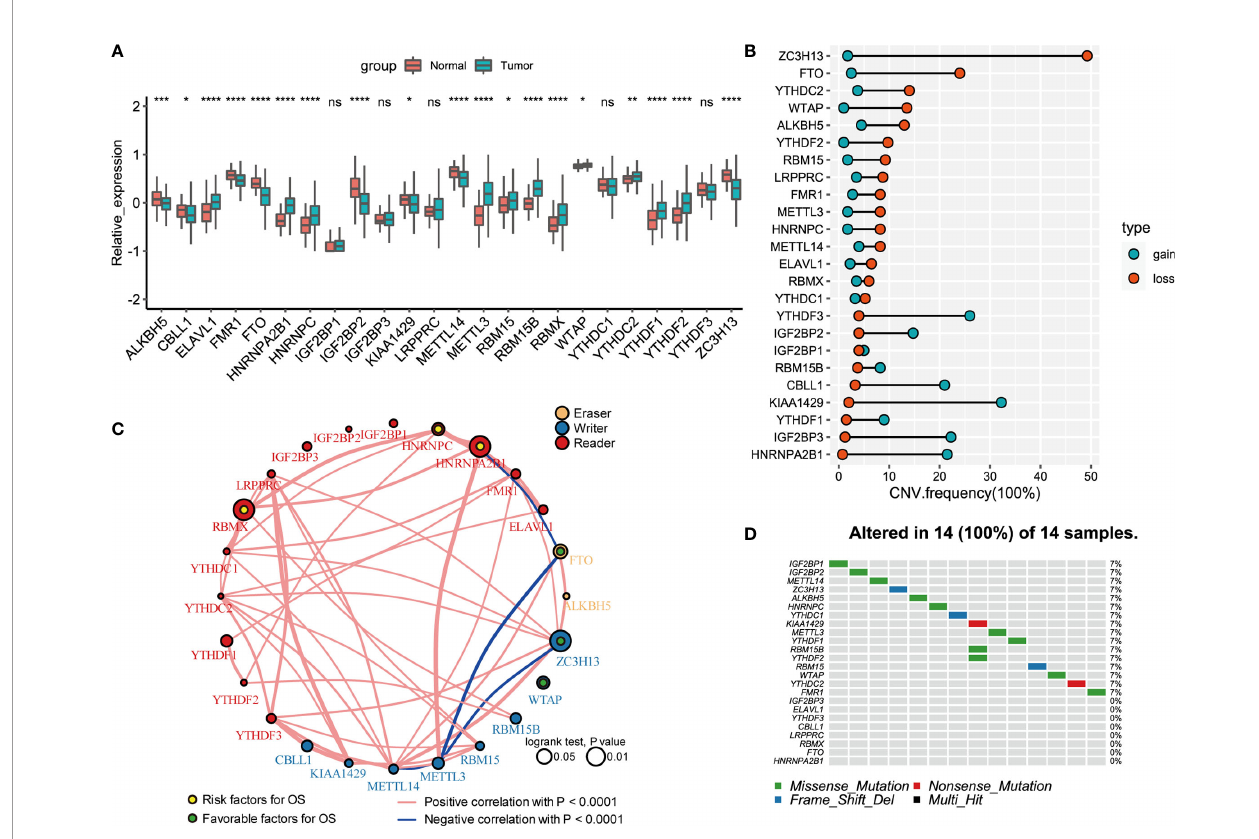
FIGURE 1 | Landscape of genetic and expression variation of 24 m6A regulators in prostate cancer. (A) The expression of 24 m6A regulators between normal tissues and prostate cancer tissues. Tumor, red; Normal, blue. The upper and lower ends of the boxes represented interquartile range of values. The lines in the boxes represented median value, and black dots showed outliers. The asterisks represented the statistical p value (*P < 0.05; **P < 0.01; ***P < 0.001; ****P < 0.0001); ns, Not Statistically signi fi cant. (B) The CNV variation frequency of m6A regulators in TCGA database. The width of the Dumbbell Chart represented the alteration frequency. The deletion frequency, blue dot; The ampli fi cation frequency, red dot. (C) The interaction between m6A regulators in gastric cancer. The circle size represented the effect of each regulator on the prognosis, and the range of values calculated by Log-rank test was p < 0.01, p < 0.05, respectively. Yellow dots in the circle, risk factors of prognosis; Green dots in the circle, protective factors of prognosis. The lines linking regulators showed their interactions, and thickness showed the correlation strength between regulators. Negative correlation was marked with blue and positive correlation with red. The regulator type Eraser, Writer, Reader was marked with yellow, blue, red respectively. (D) The waterfall plot of tumor somatic mutation established for 24 m6a regulators. Each column represented individual patients. The number on the right indicated the mutation frequency in each gene. The down bar plot showed the proportion of each variant